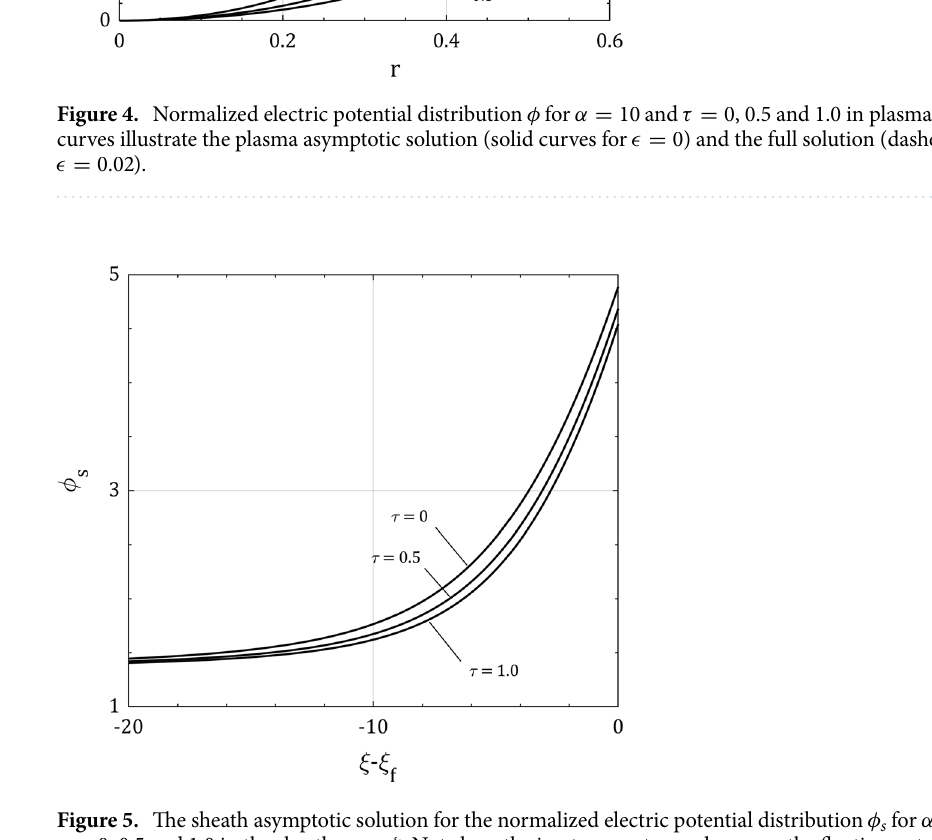
Figure 5. The sheath asymptotic solution for the normalized electric potential distribution φ s for α 0 , 0.5 and 1.0 in the sheath space ξ . Note how the ion temperature τ decreases the floating potential φ τ = does not affect on the potential at the plasma-sheath border φ b